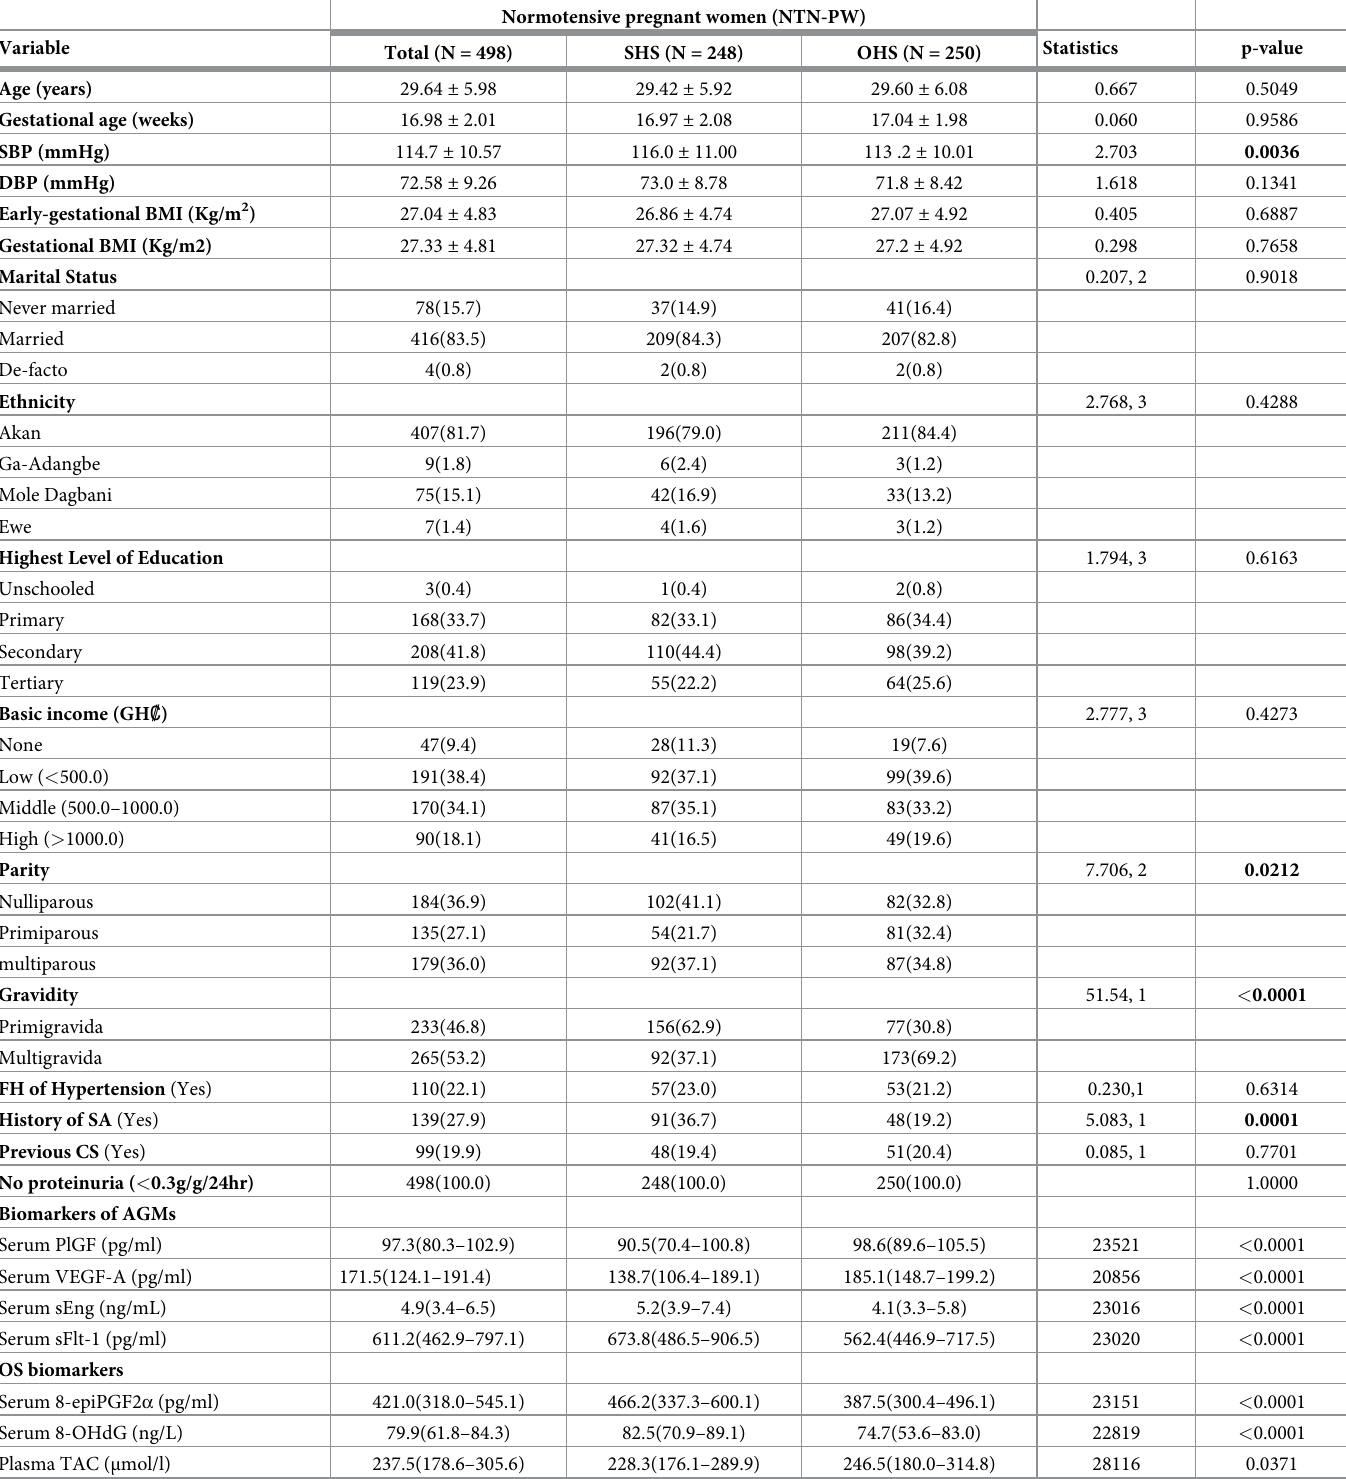
Table 1. Baseline (10-20weeks gestation) socio-demographic, obstetrics, clinical and biomarker characteristics of normotensive pregnant women who completed the study stratified by Suboptimal Health Status (SHS) and Optimal Health Status